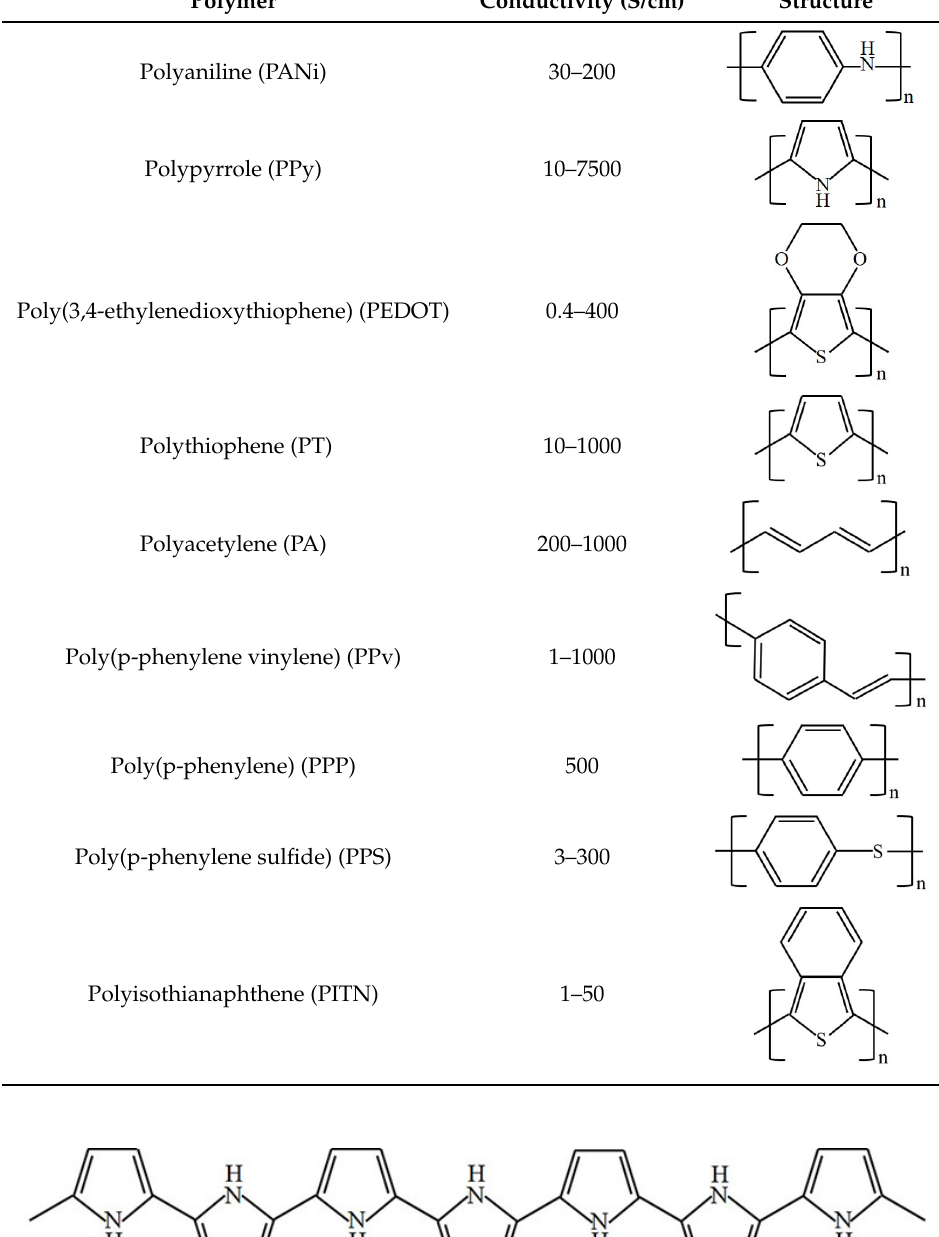
Table 1. Chemical structures of representative conducting polymers (CPs).